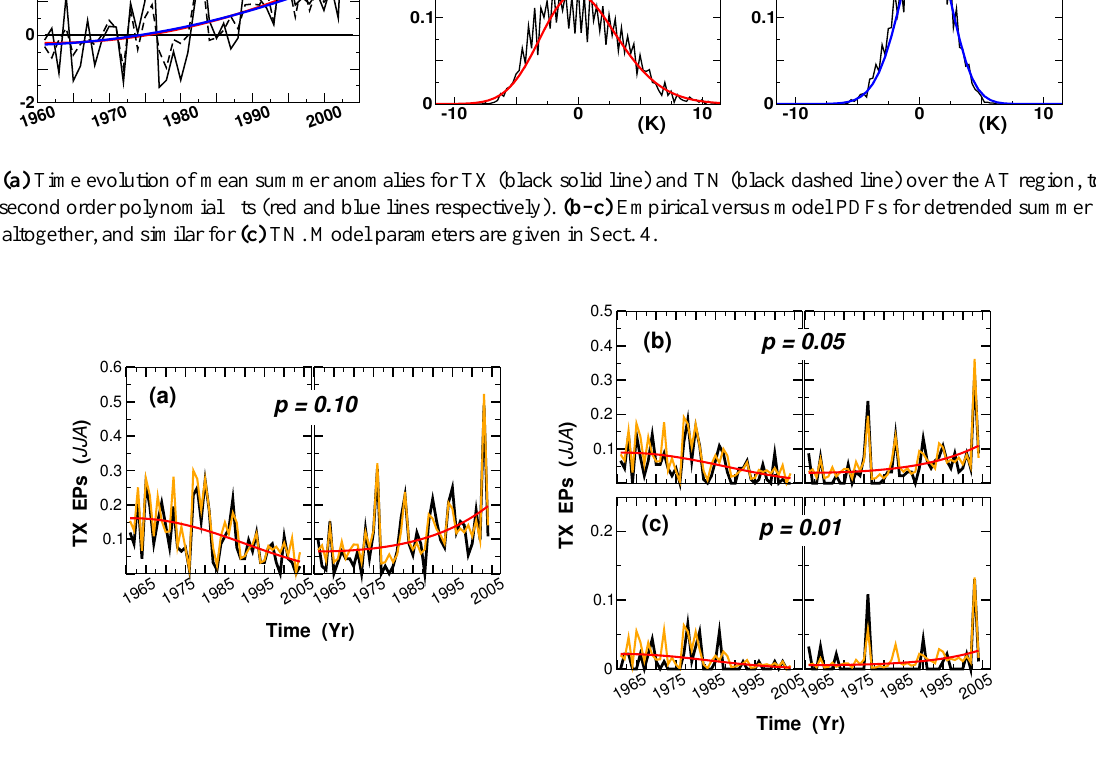
Figure 3. Modeled and observed evolution of TX EPs for AT summer anomalies and probabilities (a) p = 0 . 10, (b) p = 0 . 05 and (c) p = 0 . 01. In all cases, black lines denote the observed frequencies of (left) cold and (right) warm extremes, i.e. TX10 and TX90, and similar. Red lines are expected EPs with location parameter given by Eq. (2), and yellow lines are point-wise, expected EPs (see